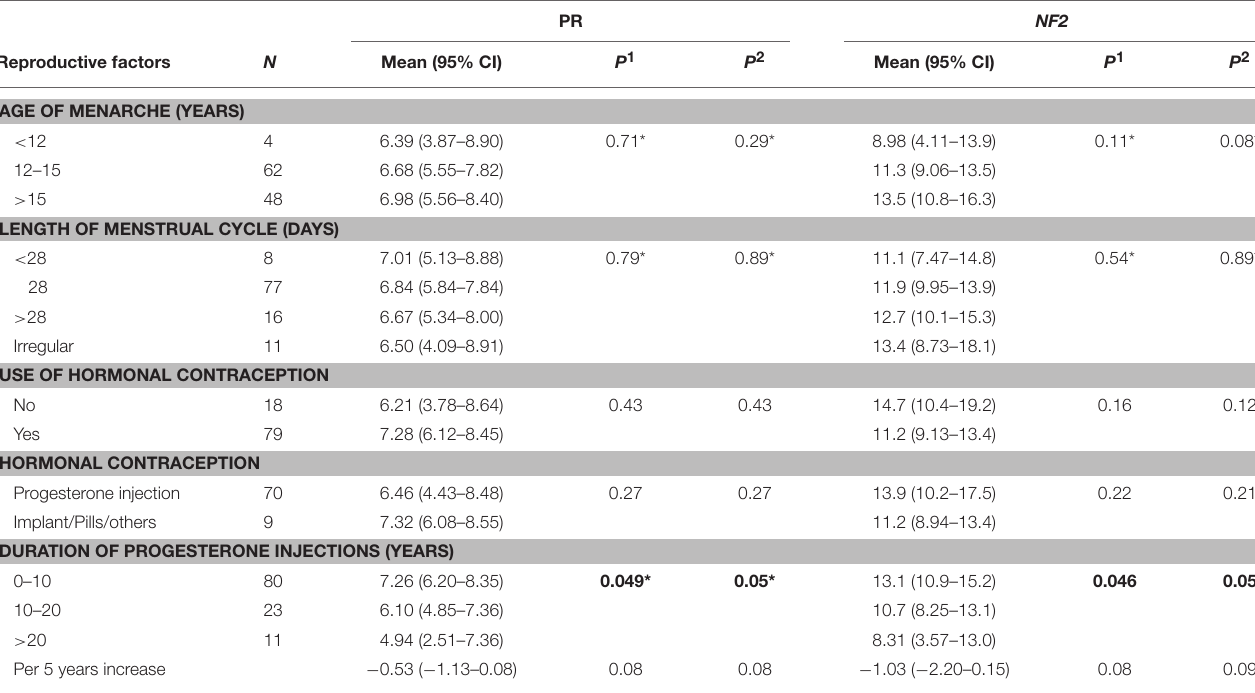
TABLE 2 | Relationships between reproductive factors and expression of PR and NF2 . PR NF2